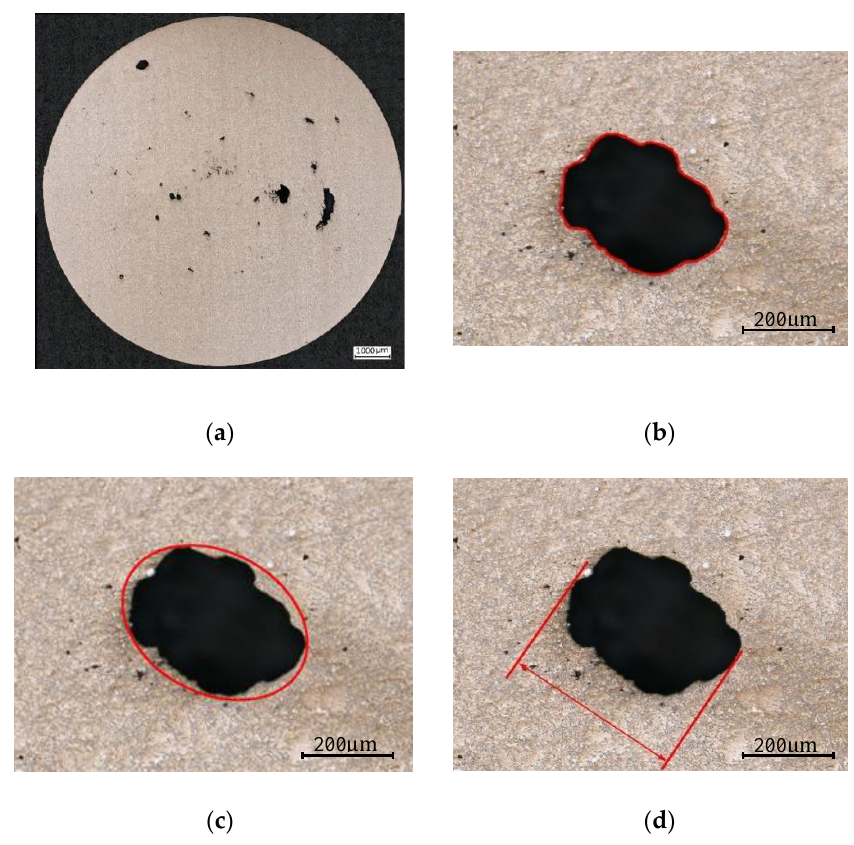
Figure 2. ( a ) an example of optical micrograph in a large specimen porosity level 3, three different defect parameters to determine the size of the defects, ( b ) actual area of the defect ( √𝐴 𝑎𝑐𝑡𝑢𝑎𝑙 ), ( c ) the area of fitted ellipse ( √𝐴 𝐸𝑙𝑙𝑖𝑝𝑠𝑒 ), and ( d ) max Feret diameter ( 𝐹𝑒𝑟𝑒𝑡 𝑚𝑎𝑥 ).